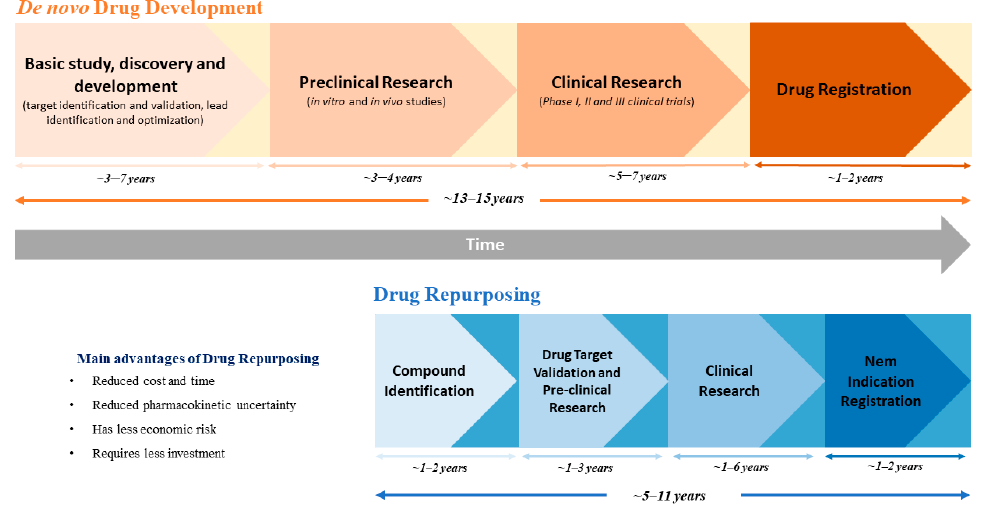
Figure 1. Schematic comparison between the processes and timeline of de novo drug development and drug repurposing. and drug